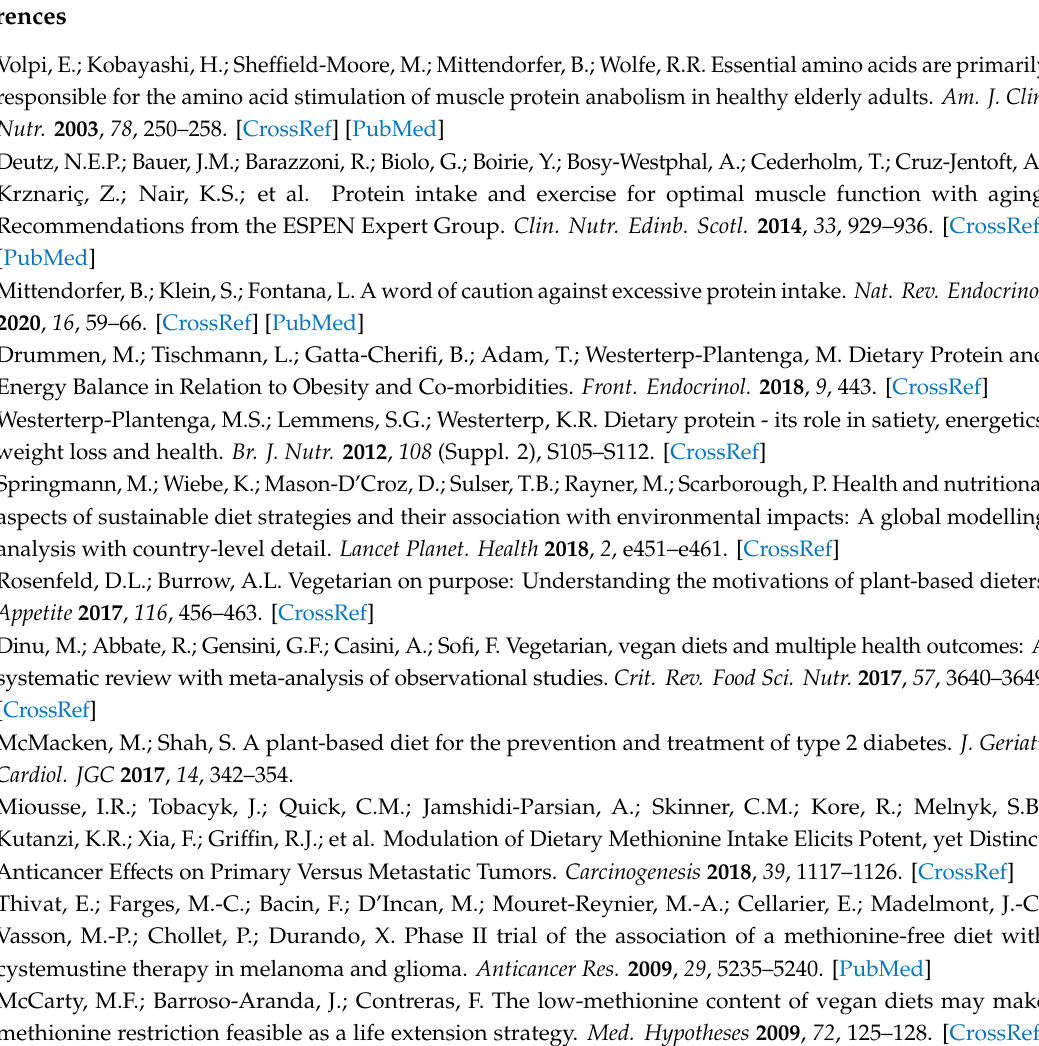
Figure S1: Metabolites in serum, Figure S2: Metabolites in liver, Table S1: Nutritional characteristics of